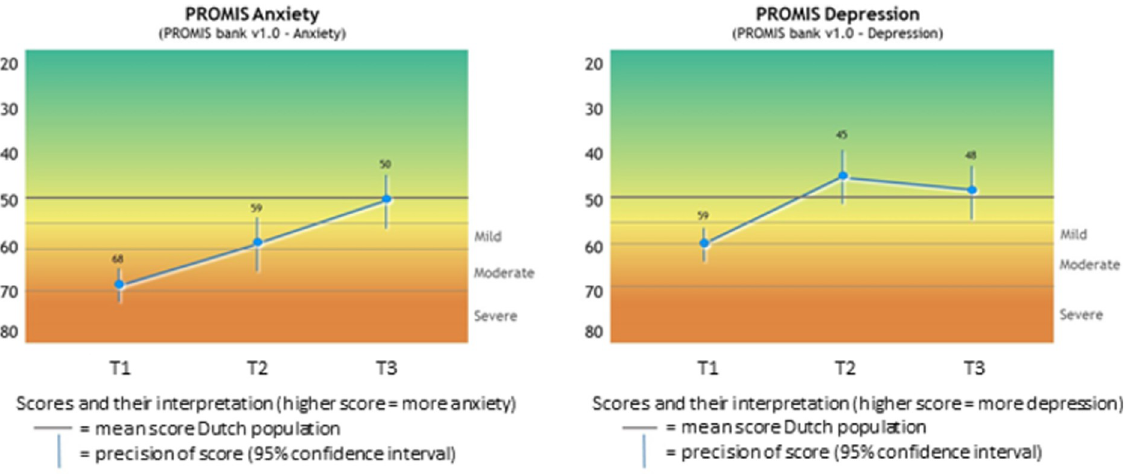
Fig 2. Visual feedback [59] of PROMIS Anxiety and Depression scores, based on Dutch mean T-scores and Dutch thresholds for mild, moderate and severe symptoms. The blue lines represent imaginary data showing the course of symptoms over three consecutive assessments (T1, T2 and